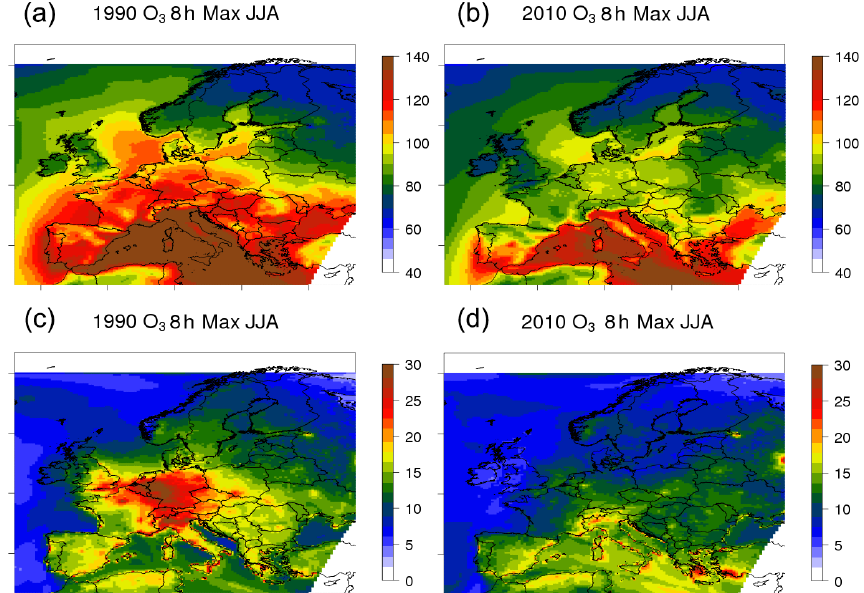
Figure 4. Eight-model ensemble results for 1990 (a, c) and 2010 (b, d) for summertime ozone peaks (June–July–August means of 8h mean